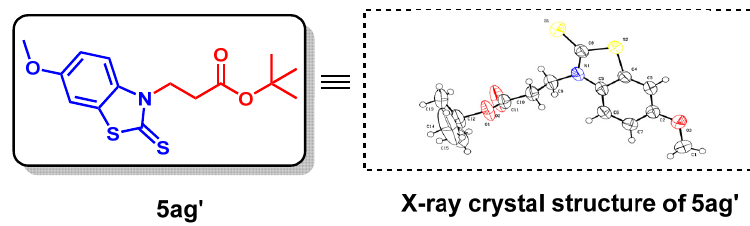
Figure 3. X-ray crystallography of by-product 5ag’ .